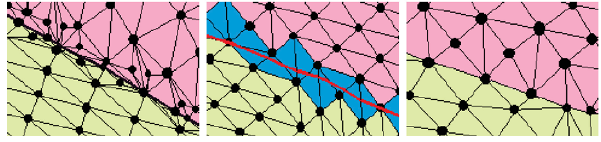
Fig. 2 Simple example of mesh segmentation. Left: Live-wire segmentation includes small triangles near the segmentation boundary. Middle: Live-wire curve (red) plotted over the input mesh; blue triangles are unlabeled. Right: Our final segmentation.